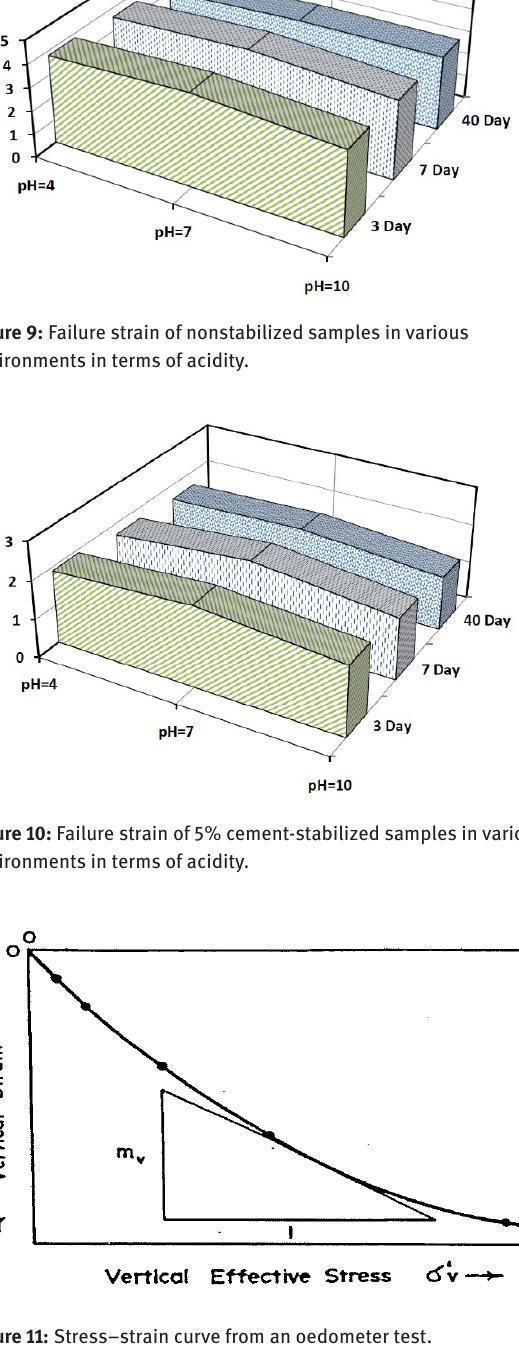
Figure 11: Stress–strain curve from an oedometer test.